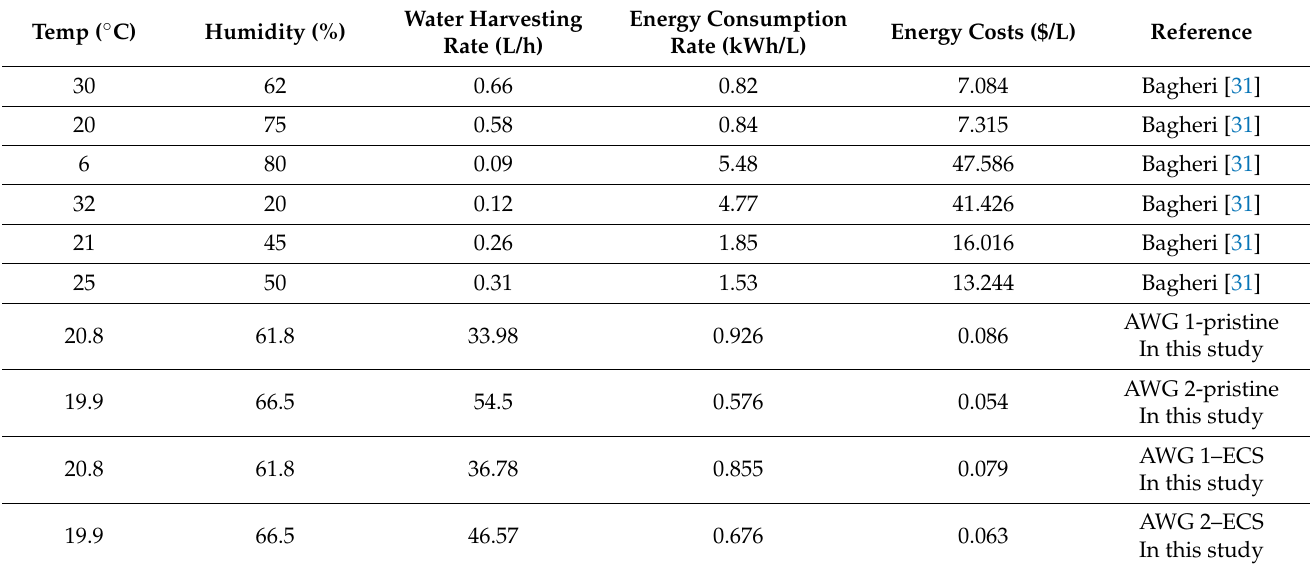
Table 5. Comparisons of water harvesting rate, energy consumption rate, and energy